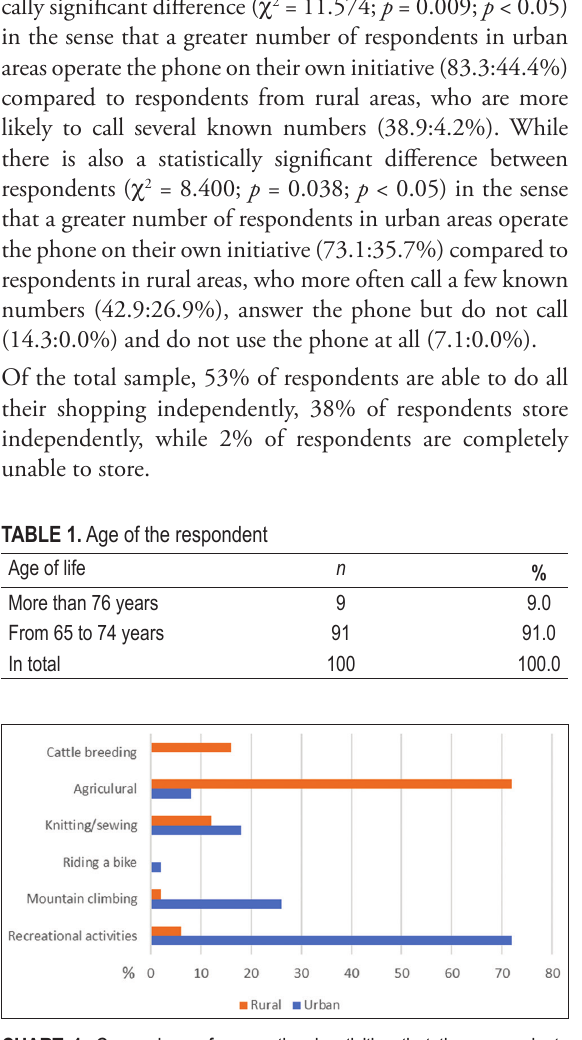
CHART 1. Comparison of occupational activities that the respondents engage in according to